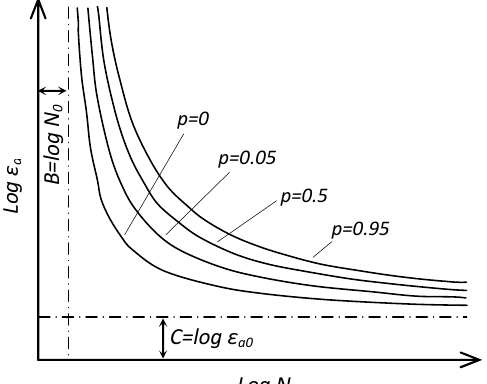
* , and the strain amplitude, ε * : p - ε -N field. f a a